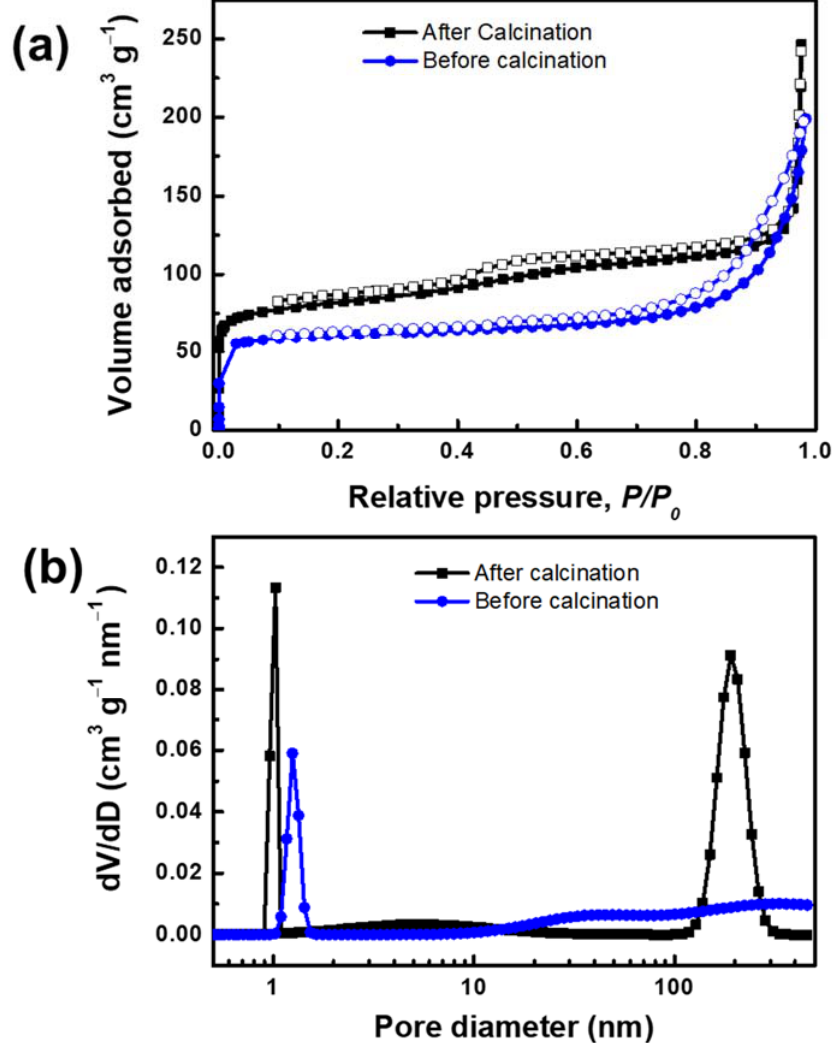
Figure 3. ( a ) N 2 adsorption and desorption isotherm and ( b ) pore size distribution of MLSil-1Ns-15d confirming the microporous and mesoporous structure of the sample before and after calcination at 550 °C for 5 h.